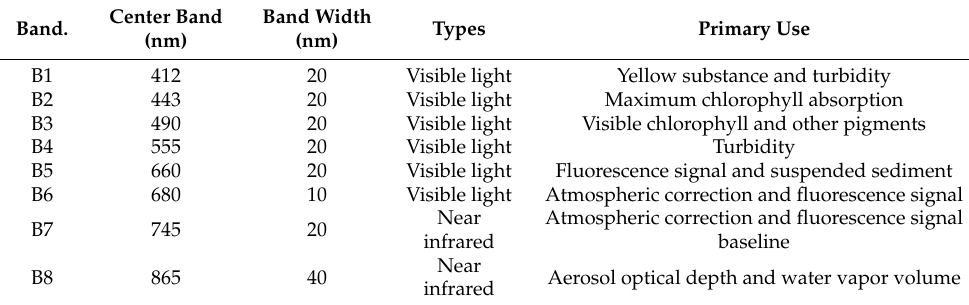
Table 1. Characteristics of the spectral bands on GOCI